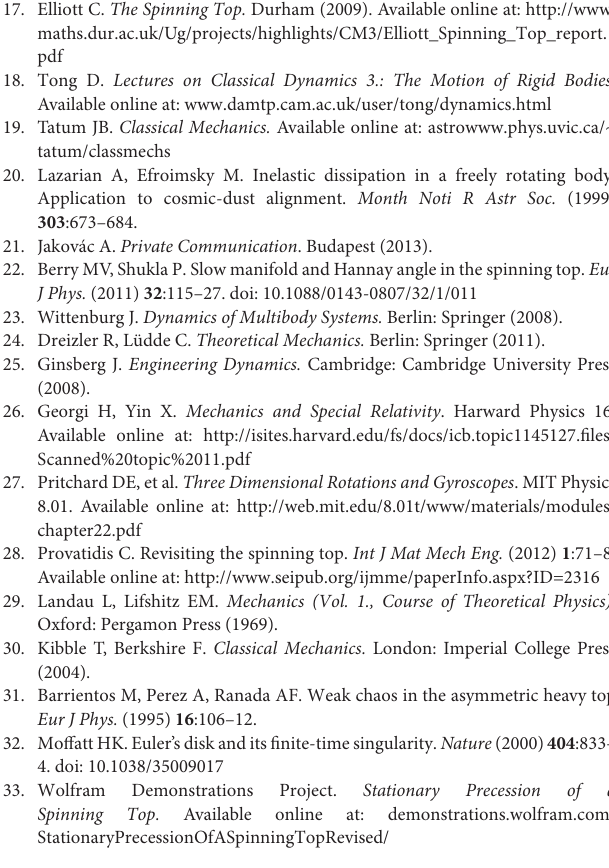
Frontiers in Physics |